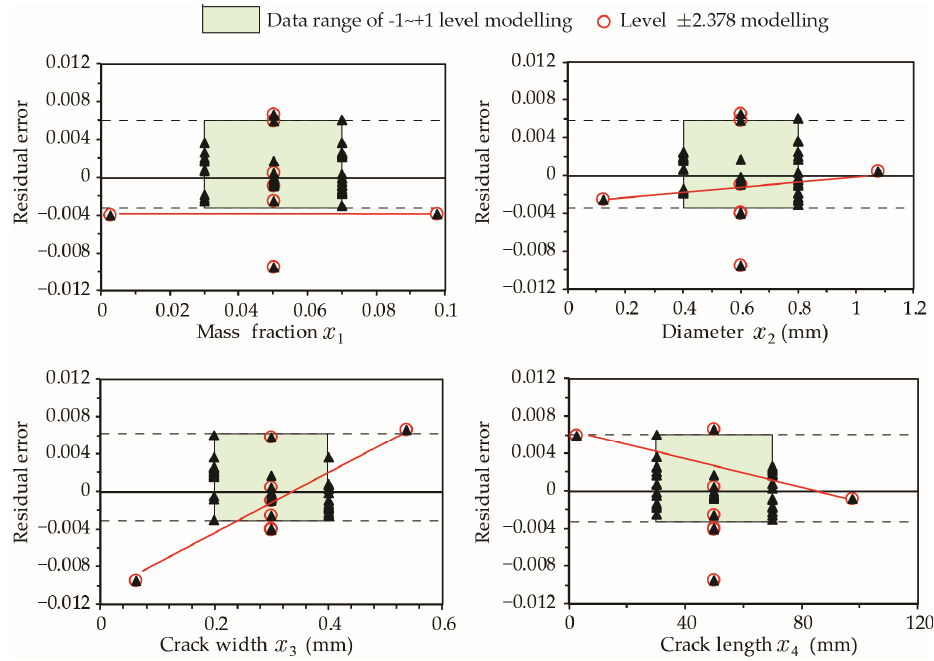
Figure 12. Influence of individual factors on residual errors for R f − 95 . The results of extreme cases at Level ±2.378 are connected by a red line.